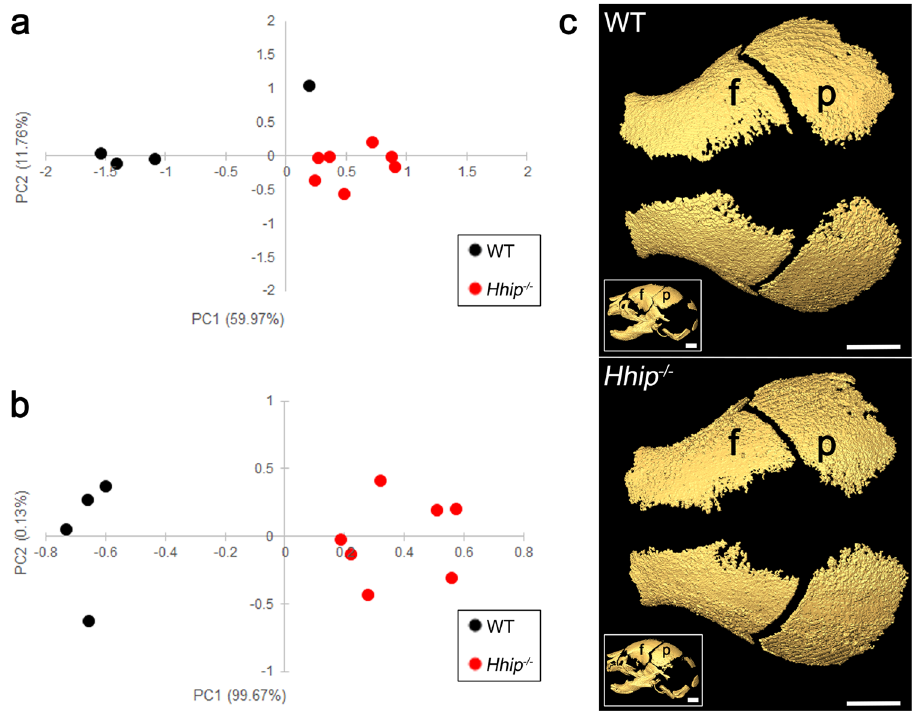
Fig. 7 Results of principal components analyses (PCA) of data from microcomputed tomography (microCT) imaging of Hhip − / − heads at E18.5. Scatter plots of results of PC1 and PC2 scores based on PCA analysis of unique linear distances among 3D landmarks for a form and b shape (adjusting for the effects of allometry) of WT ( n = 4) and Hhip − / − ( n = 7) skulls. c 3D reconstruction of microCT images showing dorsal views of the frontal (f) and parietal (p) bones of WT and Hhip − / − calvaria. Insets show lateral views of the whole skull. Images are representative n = 4 WT and seven Hhip − / − skulls. Scale bars, 1